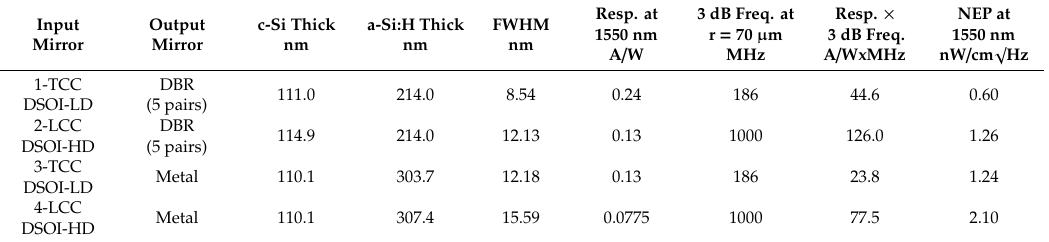
Table 2. Summary of the main performance of the optimized TCC and LCC Fabry–P é rot graphene / Si Schottky PD provided by both DBR and MR as output